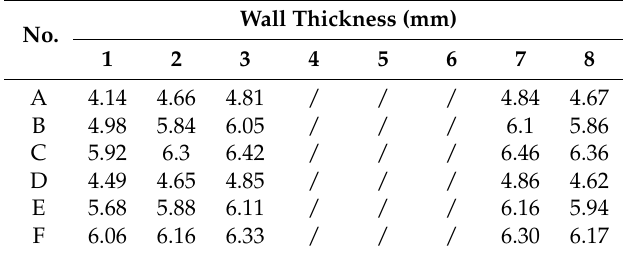
Table A2. Testing results for Fields A–F in Chongqing area.